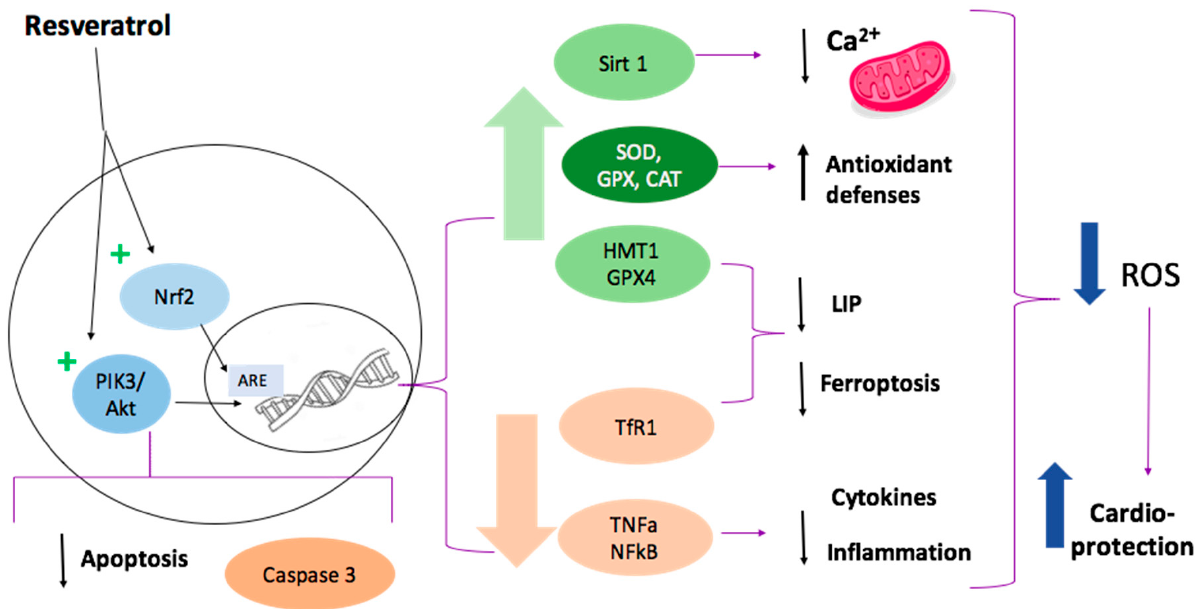
Figure 4. Representation of resveratrol cardioprotective effect. Resveratrol activates the Nrf2 signaling pathway, increasing the expression of antioxidant enzymes. It also reduces the expression of pro-apoptotic proteins, such as caspase 3, via the PI3K/Akt pathway. Other effects are the reduction of inflammation and ferroptosis, which has been associated with reduced expression of TNF α , Nf κ B, TfR1, and increased activity of GPX4 after administration of resveratrol. The activation of SIRT1 is related to a decrease in intramitochondrial calcium concentration, which diminishes mitochondrial ROS production.